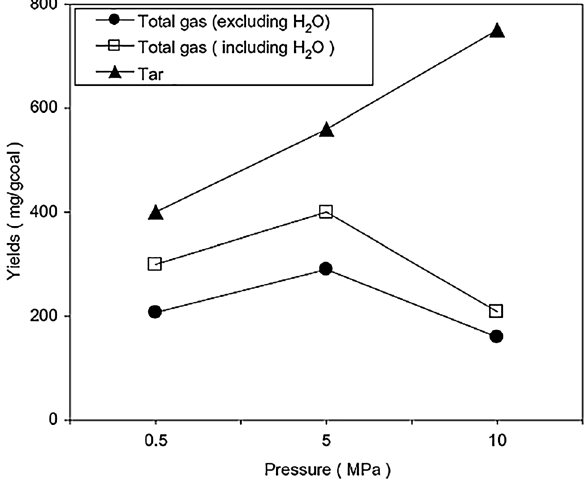
Fig. 8 Product yields versus pressure, Canel et al.